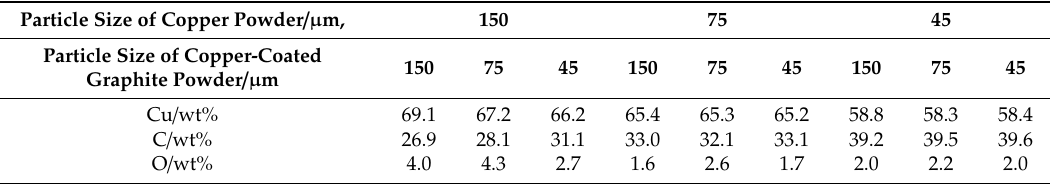
Table 1. The content of di ff erent elements in the corresponding area in Figure 7 / wt%. Particle Size of Copper Powder / µ m, 150 75 Particle Size of Copper-Coated Graphite Powder / µ m 150